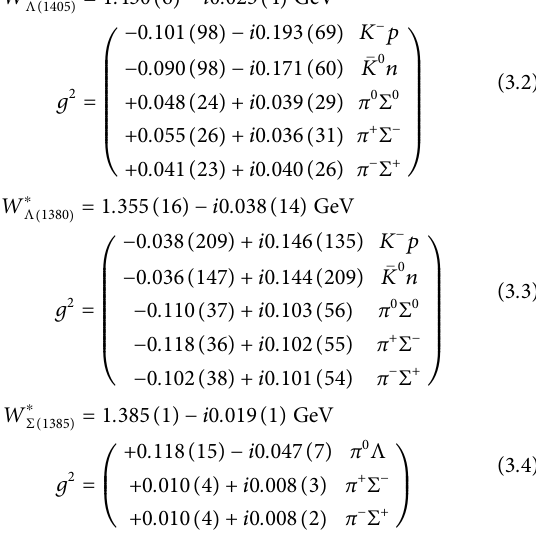
with 1 σ error bars from the re-sampling procedure reported as, e.g., +1.234 (56) = +1.234 ± 0.056 etc . Couplings obtained in other fi t